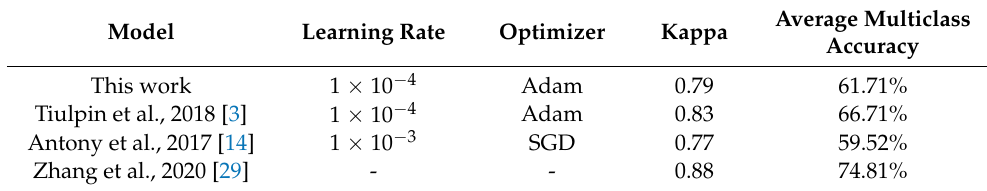
Table 4. Model comparison to other models according (kappa an average multiclass accuracy).